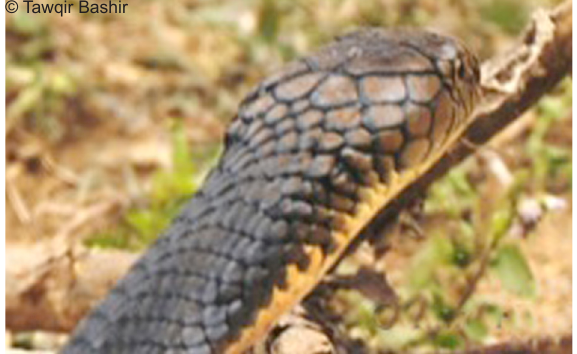
© Tawqir Bashir Image 4. Showing distinct Image 3. Showing the Λ shaped bands on the supralabial and ocular scales hood pattern of reptiles along an eastern Himalayan elevation gra- dient, India. Acta Oecologica 36(1):